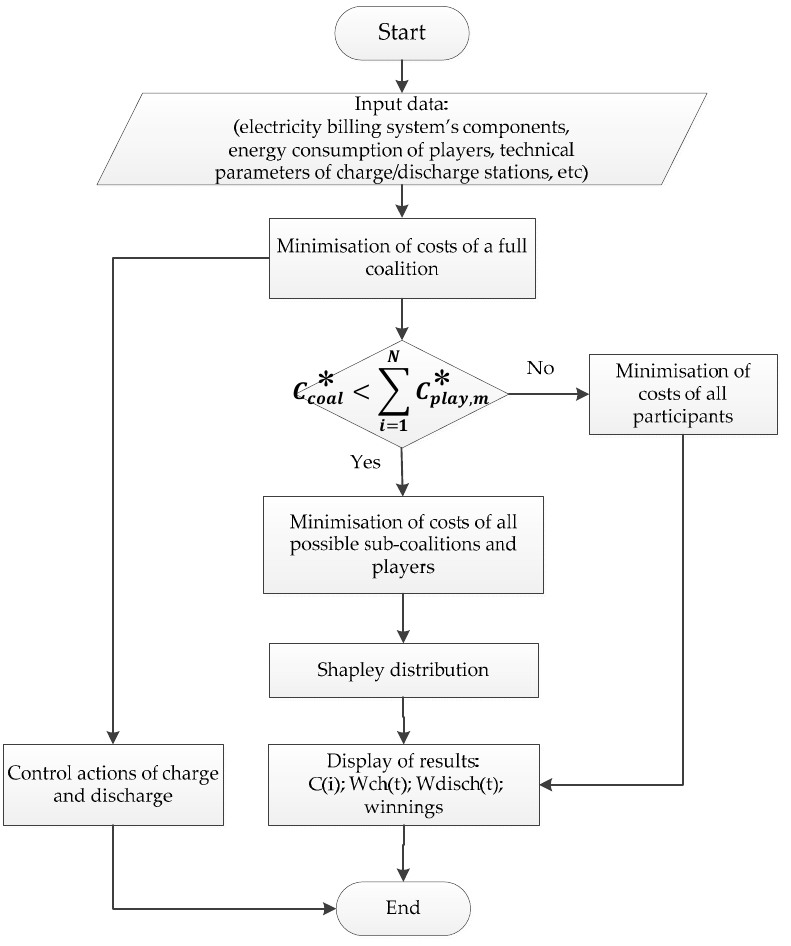
Figure 2. A simplified diagram of charging / discharging scheduling (where C is the minimized cost of energy consumed by each m -th player, separately).